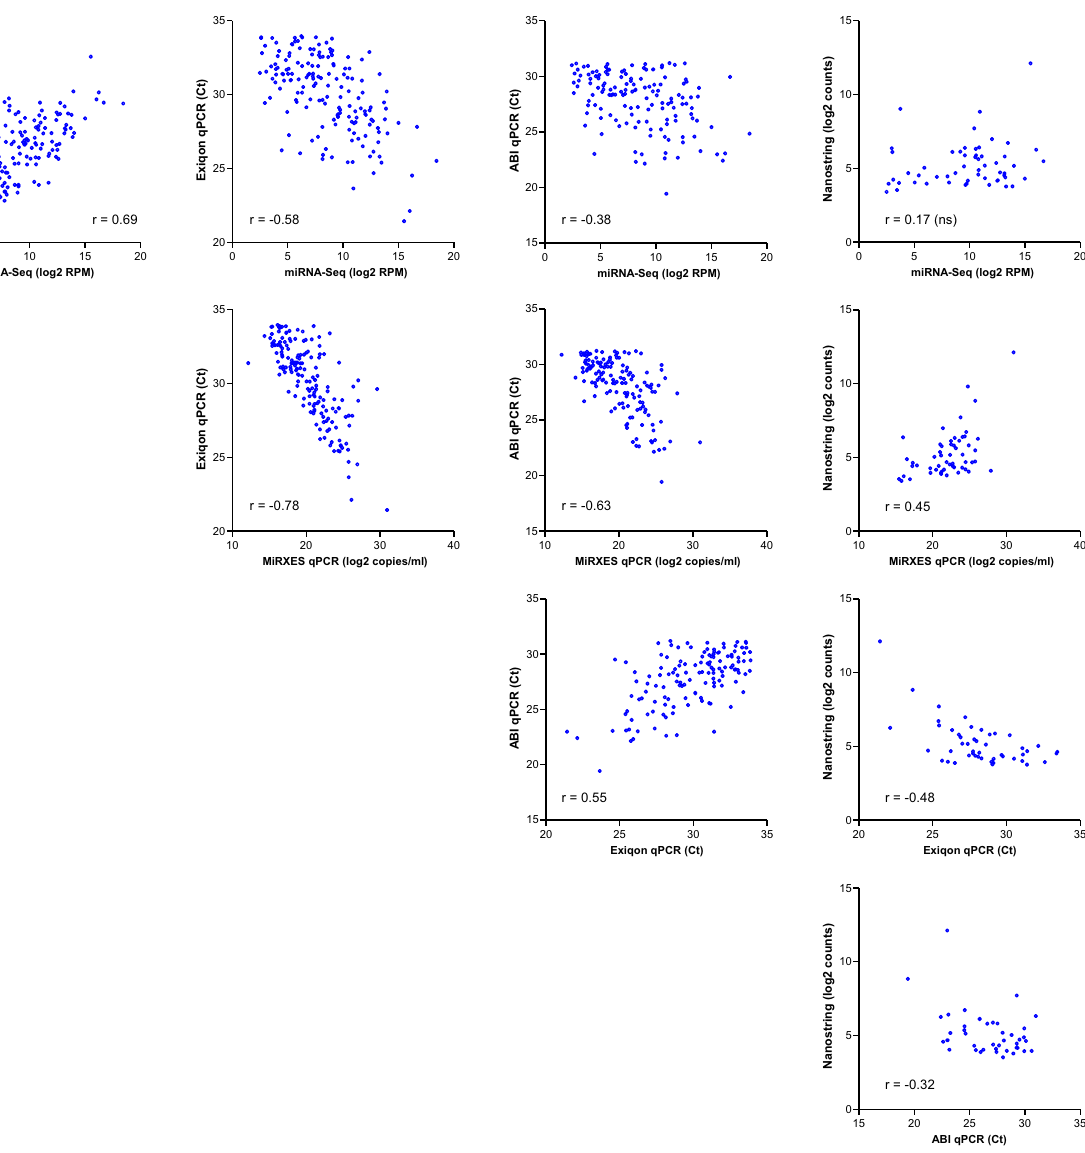
Figure 3. Inter-platform correlation. Pairwise inter-platform correlation in expression levels for miRNAs that were detected above the LLOQ in Ref. Serum. The miRNAs measured by qPCR do not include those in the “expanded” panel (see text). r Spearman’s correlation coefficient, ns not significant (p >